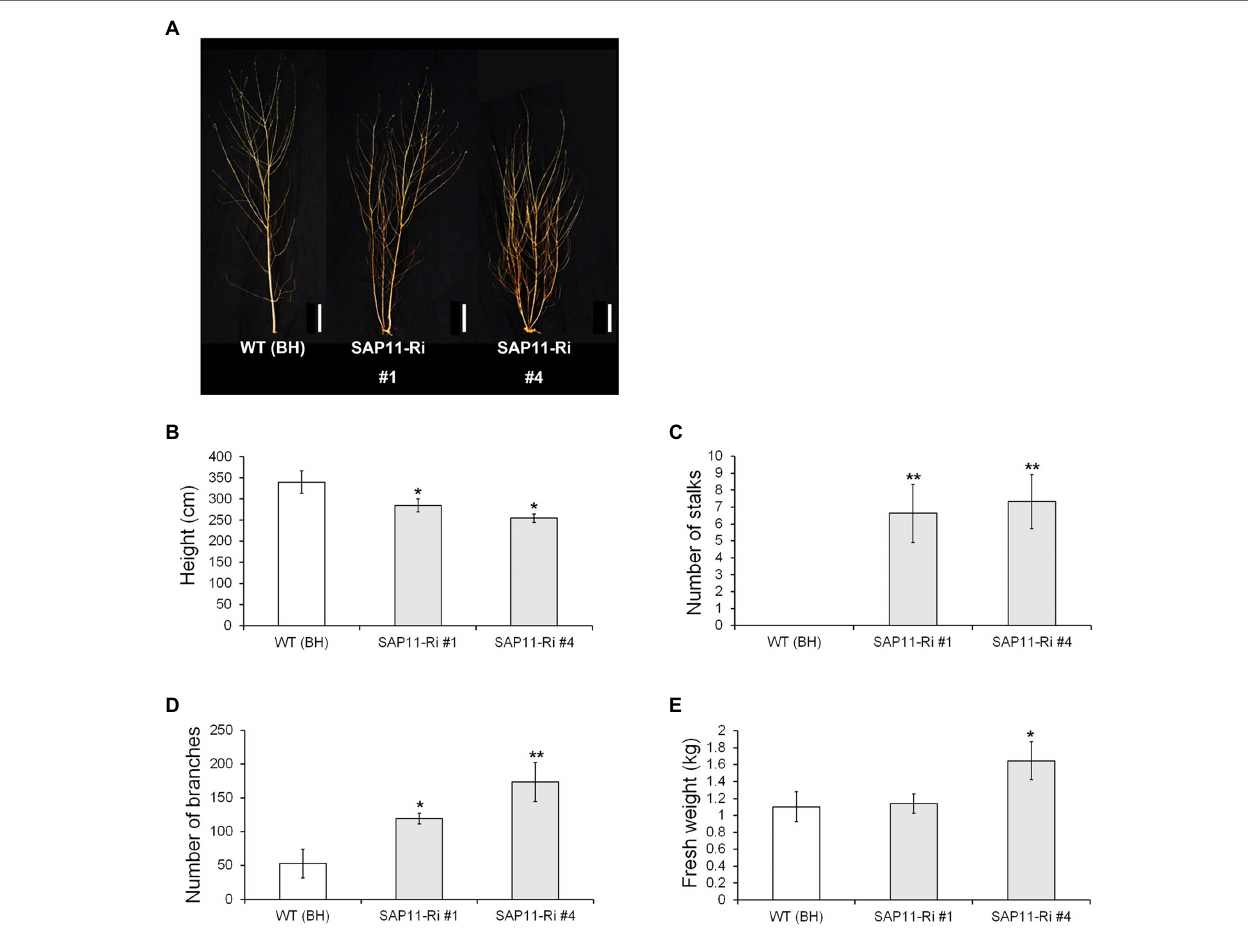
FIGURE 6 | Growth-related data recorded from SAP11 -engineered poplars of the field trial during second cultivation cycle. (A) Image of representative WT (clone BH) and transgenic poplar grown in the LMO field. ( B-D ) Shoot height (B) , number of side stalks (C) and number of sylleptic branches (D) in WT and transgenic poplars ( n = 10). (E) Aboveground biomass yields of the WT and SAP11 -engineered poplars. The values represent the means ± standard deviations (SDs) of three biological replicates. Asterisks indicate significant differences by student t -test (* p < 0.05, ** p < 0.005), Scale bar = 30